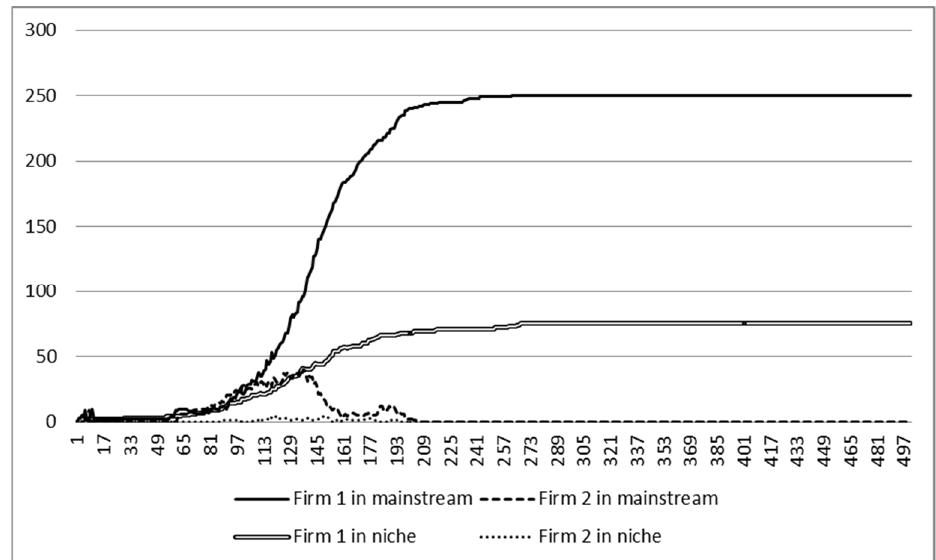
Figure 6. Firm 1 dominates in the mainstream and niche segments when the network effect is strong (the consumers’ preferences in the mainstream segment are heterogeneous).